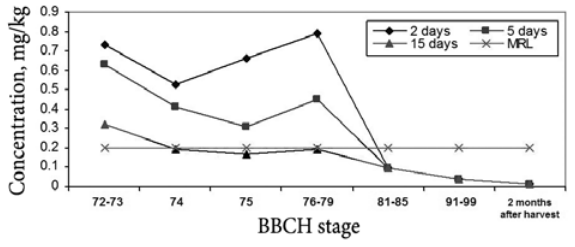
Fig. 17. Degradation of triadimenol in Jonathan apples